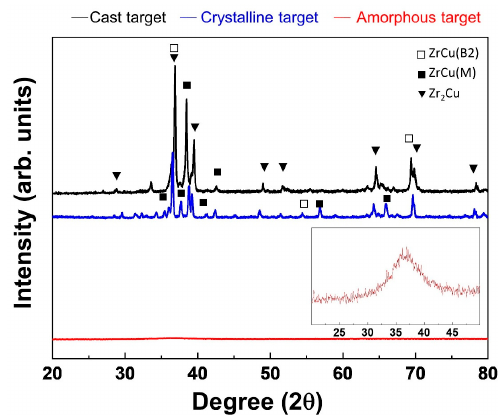
Figure 3. XRD results for targets prepared using different manufacturing methods. (Inset) Amorphous target XRD results between 20° and 50°.